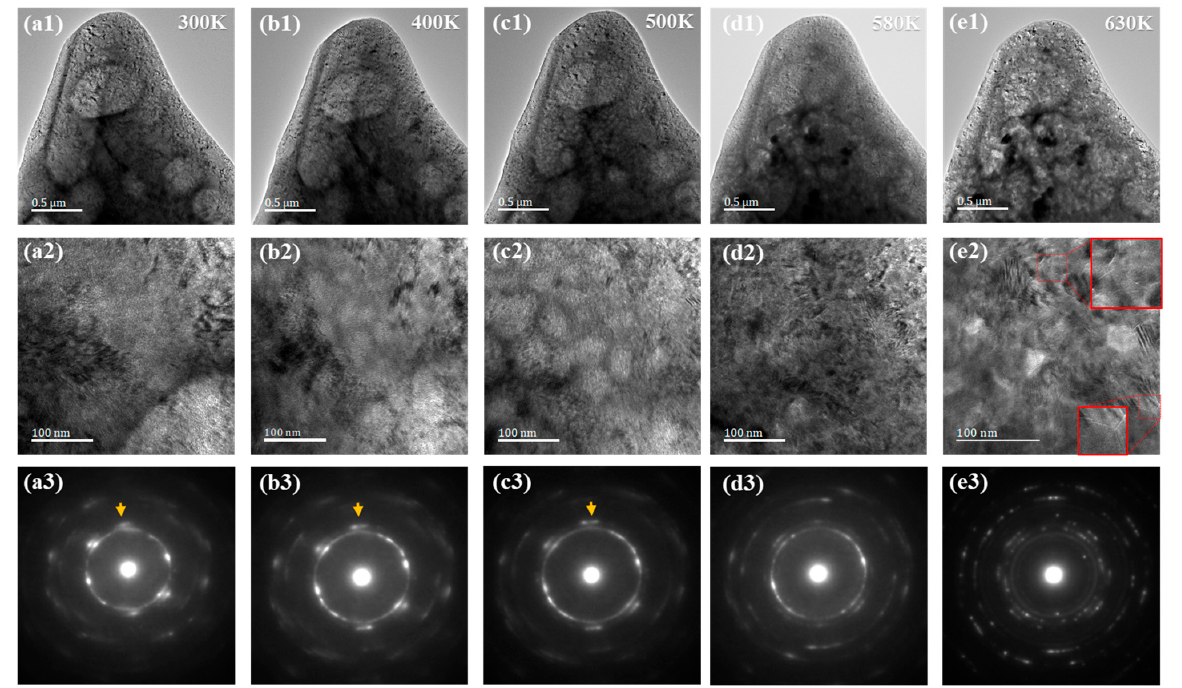
Figure 4. The TEM micrographs and SADPs of the 90% rolled specimens at ( a1 – a3 ) room temperature of 300 K and after heating to ( b1 – b3 ) 400 K, ( c1 – c3 ) 500 K, ( d1 – d3 ) 580 K, and finally ( e1 – e3 ) annealing at 630 K for 1 h. The middle images are the top images at a larger magnification and also selected areas for the bottom SADPs.